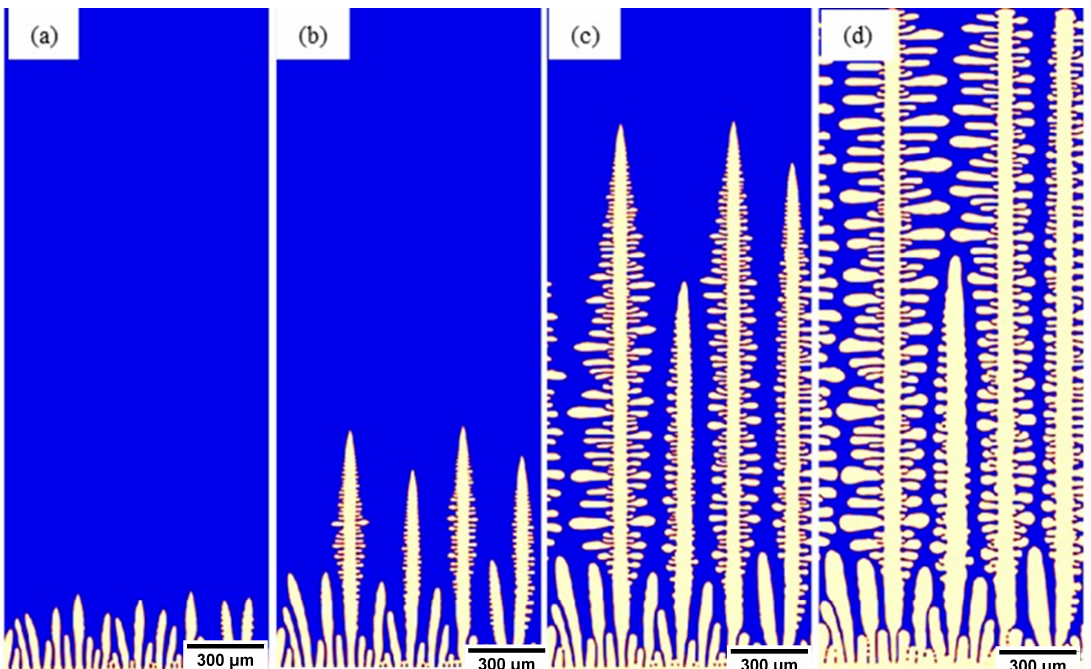
Figure 10. Micress simulation of S32101 chill surface with 100 °C superheat. ( a ) SDAs formation, ( b ) dendrite competition, ( c ) primary dendrite arm selection, and ( d ) dendrite tip across domain.